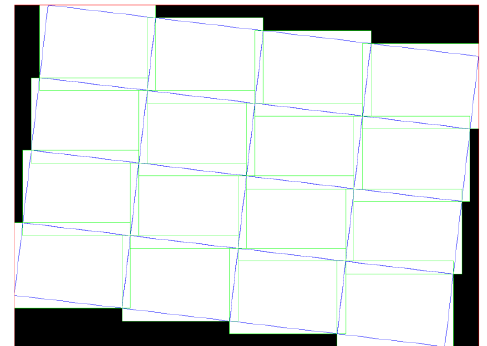
Figure 4. When we mosaic a group of orthoimages (e.g. 4 x 4 orthos) in one single image file empty wedges appear (in black in the image). These “null” wedges cause a lot of problems afterwards.